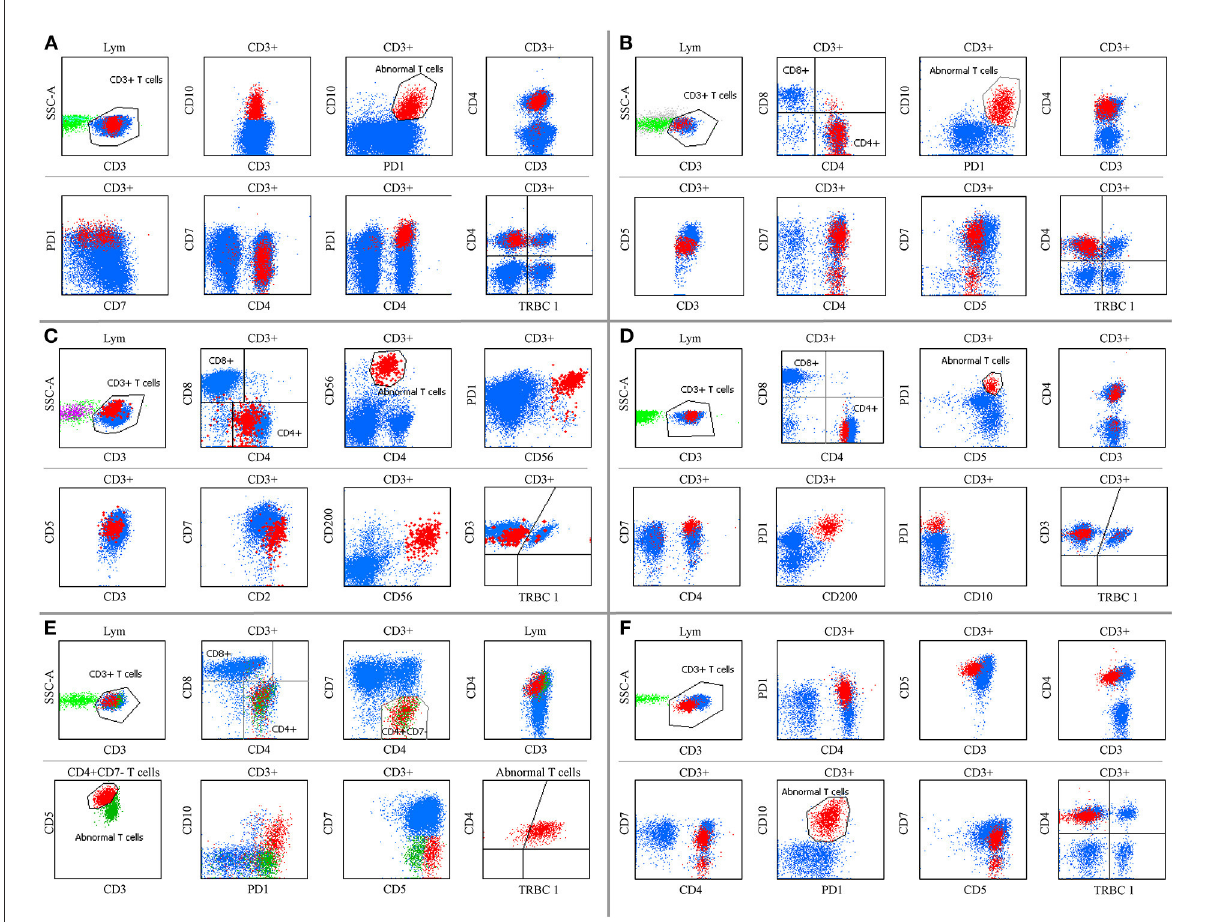
FIGURE5 Some AITL immunophenotyping could not be detected by the T-cell screen tube. (A,D,E,F) show BM specimens. (B,C) show tissue samples. (A) Aberrant T cells were CD3 + , CD4 + , and CD10 + with bright PD-1 expression, and CD7 was partially expressed. (B) Neoplastic T cells were CD4 + , CD7 + , and CD10 + with slightly diminished CD3 and CD5 expression and bright PD-1 expression. (C) Tumor cells were CD3 + , CD5 + , CD7 + , and CD200 + with diminished CD4 expression and bright CD2, CD56, and PD-1 expression, and CD10 was negative (not shown). (D) Abnormal T cells were CD3 + , CD4 + , CD5 + , and CD200 + with bright CD7 and PD-1 expression, and CD10 was negative. (E) An extremely low ratio of CD7 negative T cells was CD3 + , CD4 + , and CD10 + with bright CD5 and PD-1 expression. The immunophenotyping of neoplastic T cells shifted over time (E,F) before and after therapy, respectively. TRBC1 did not show polyclonal expression in these